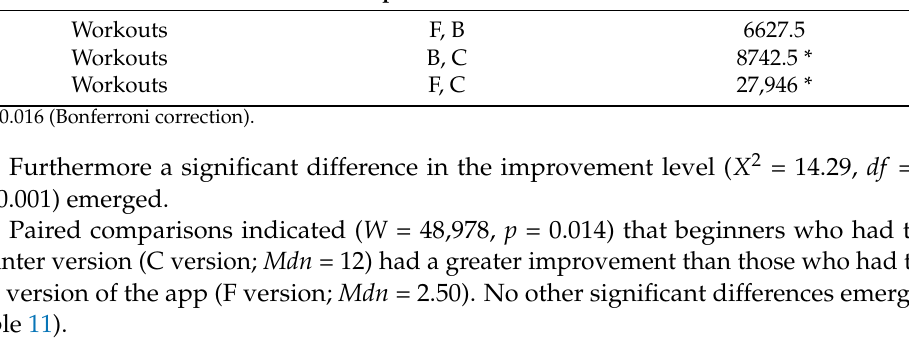
Table 10. Post-hoc Mann–Whitney tests results for workouts in Beginners. Factor Compared Conditions W Workouts F, B 6627.5 Workouts B, C 8742.5 * Workouts F, C 27,946